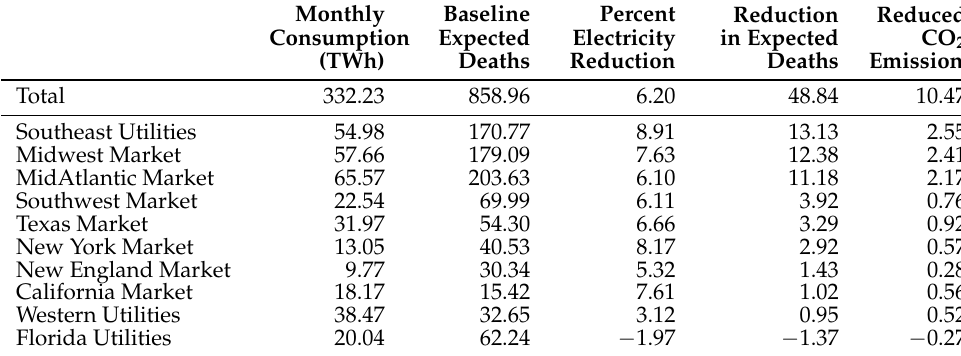
Table A4. Monthly reduction in deaths from electricity generation.